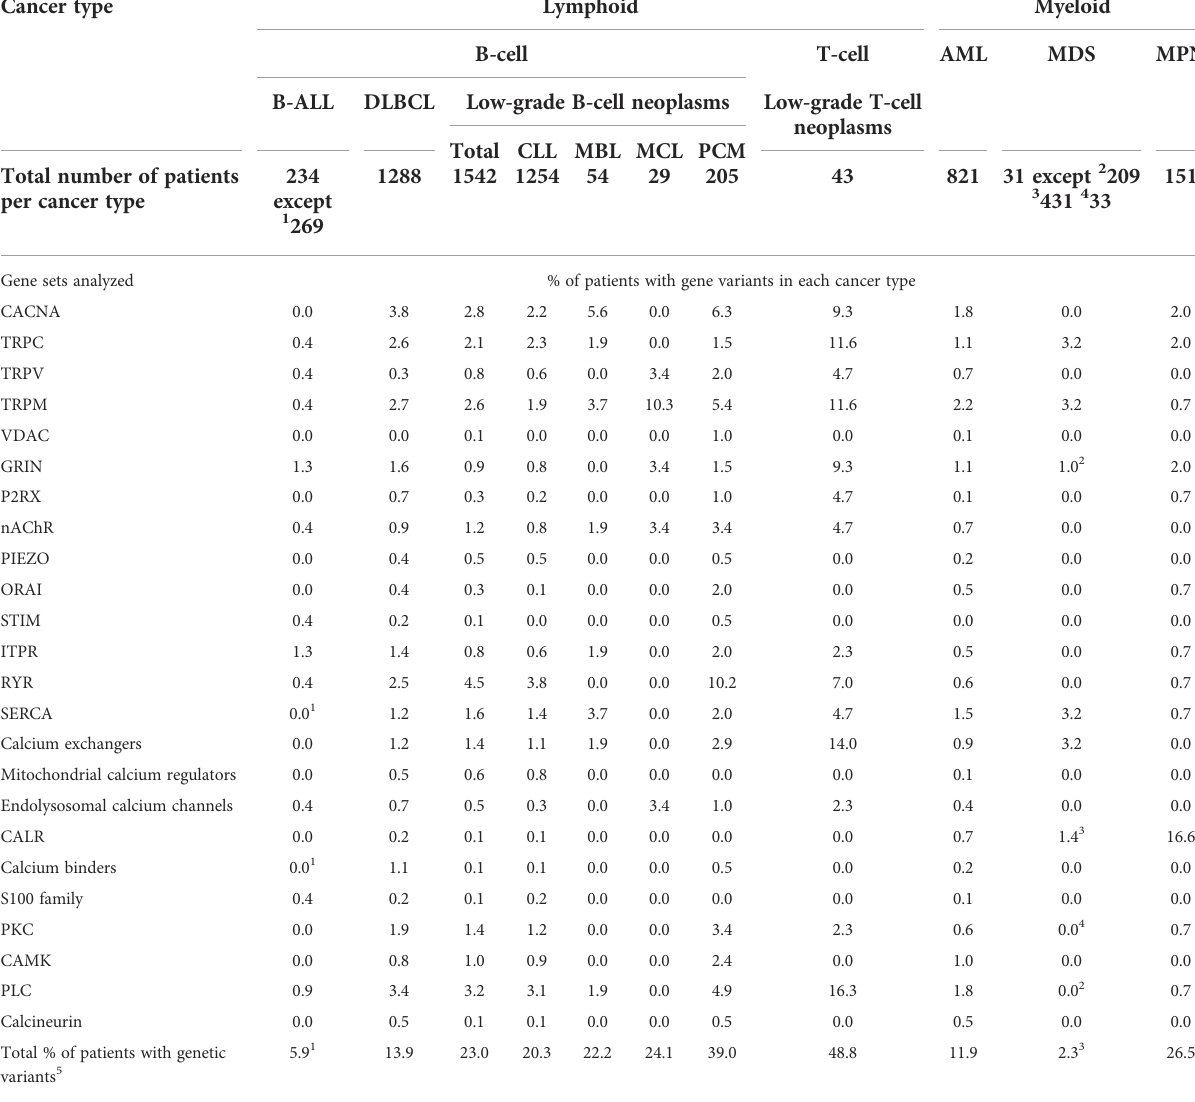
TABLE 3 Frequencies of genetic variants in the calcium-toolkit encoding genes documented in lymphoid and myeloid cancer databases. Cancer type